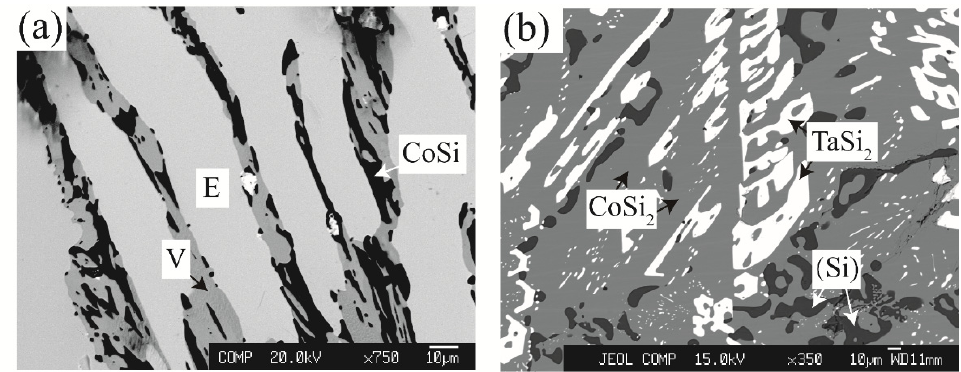
Figure 2. Typical ternary micrograph images obtained of ( a ) Co 34 Ta 26 Si 40 alloy annealed at 1100 °C for 60 days and ( b ) Co 26 Ta 7 Si 67 alloy annealed at 1100 °C for 60 days .